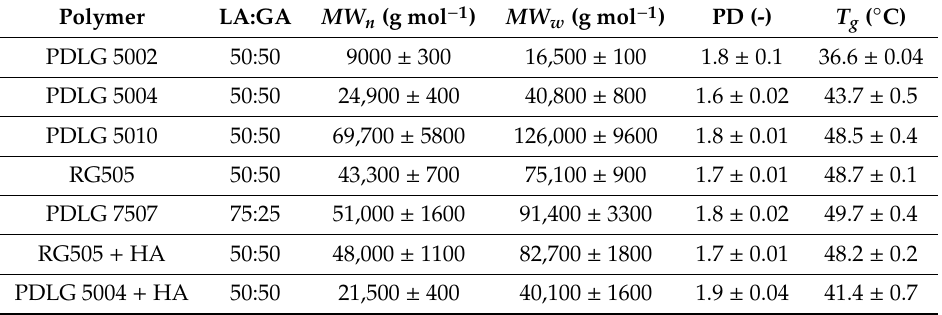
Table 1. Investigated polymers and their initial properties. Values are expressed as average ± standard deviation.